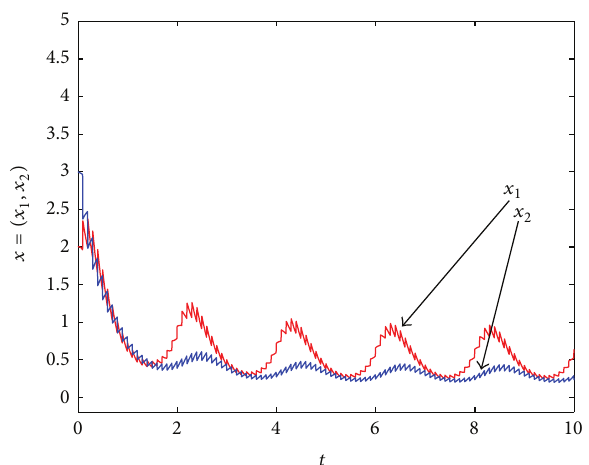
Figure 6: The time series and phase of the extinction of species x